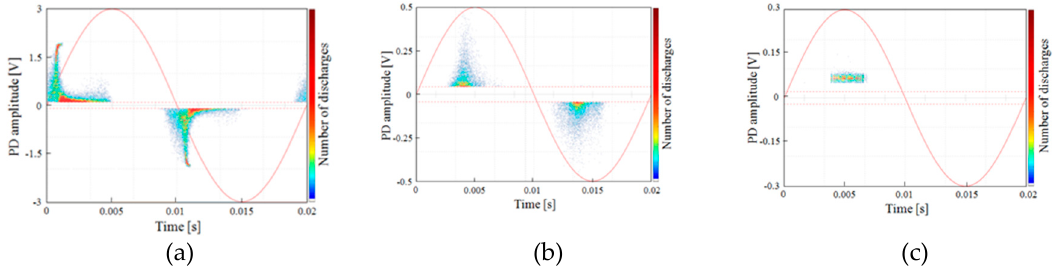
Figure 10. PRPD patterns of ( a ) internal 2.3 kV, ( b ) surface 2.0 kV, and ( c ) corona discharges 3.0 kV.